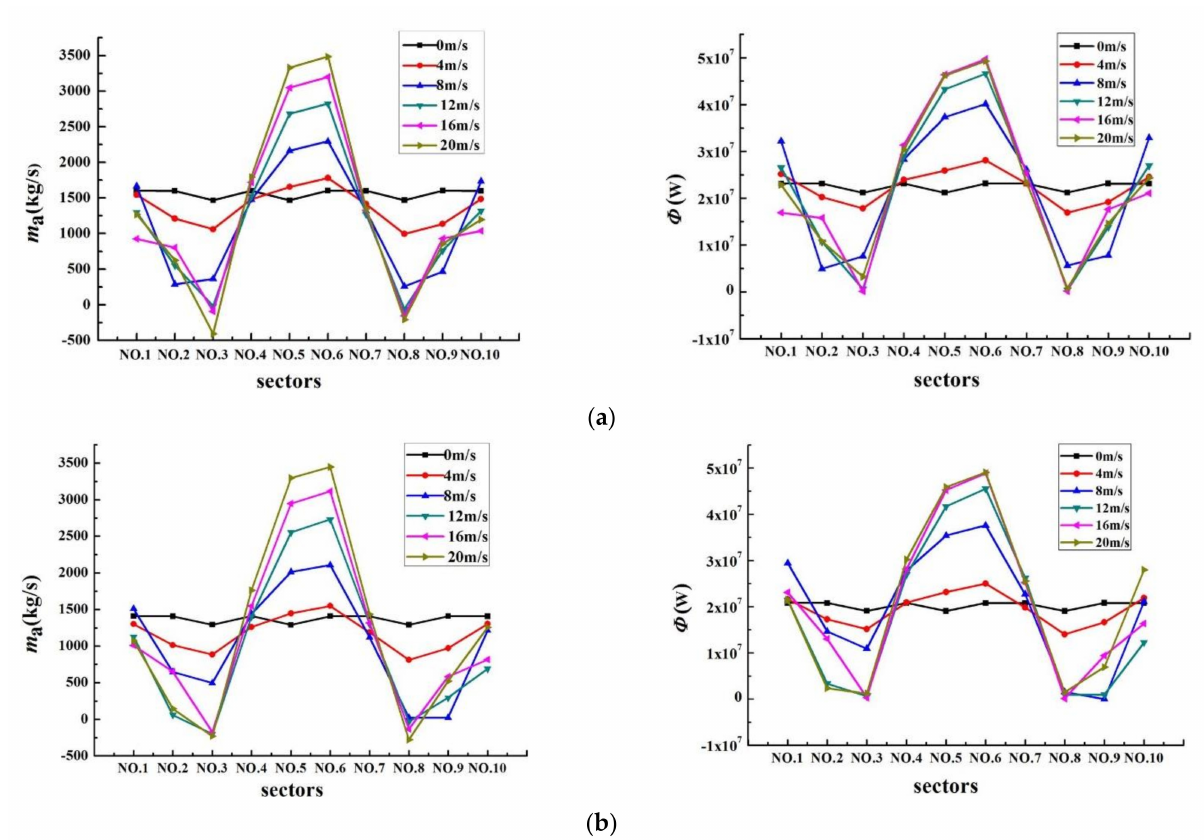
Figure 14. Distributions of local thermal and flow behaviors for air-cooled sectors of tower 1 configuration and tower 4 configuration. ( a ) Tower 1; ( b ) tower